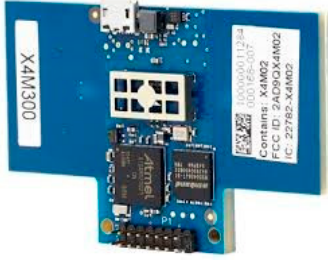
Figure 1. X4m300 UWB radar.